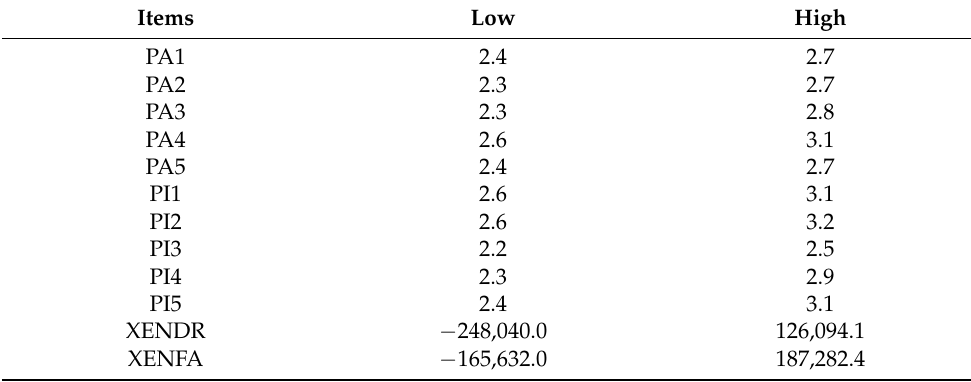
Table A1. Item means for all items by formal education groups.